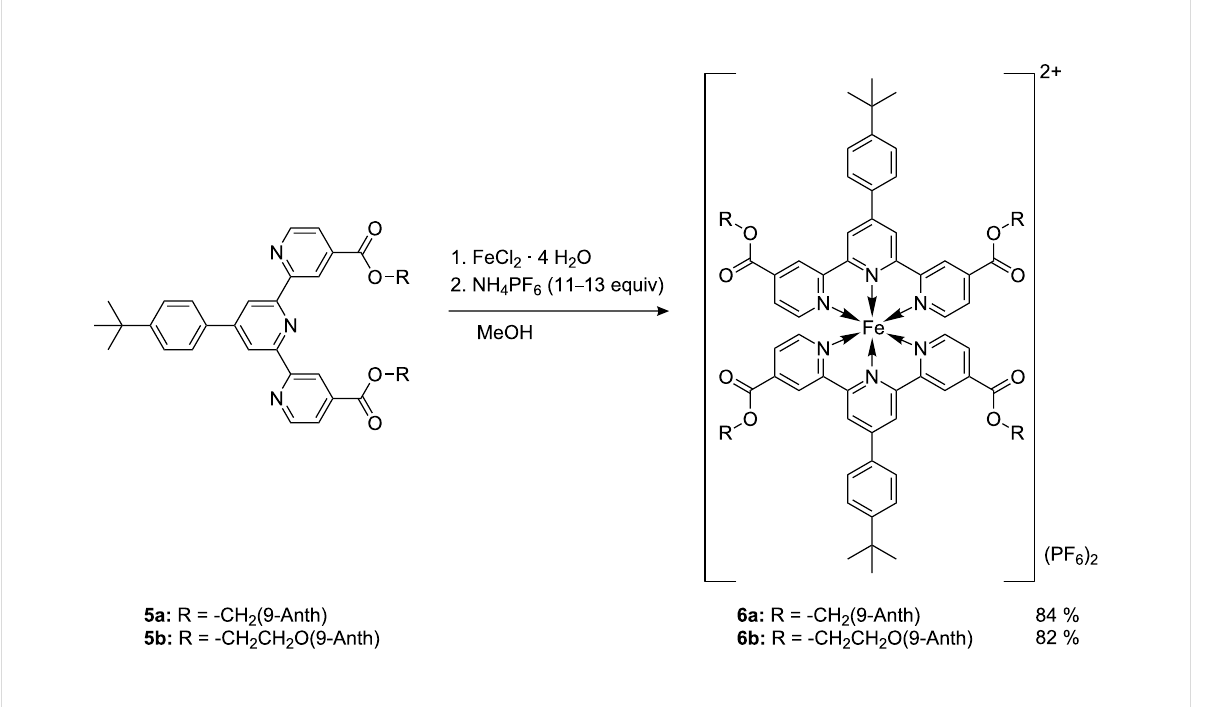
Scheme 3: Synthesis of the iron(II)-complexes 6a and 6b . The complexes 6a and 6b were obtained in high yields as dark blue solids.